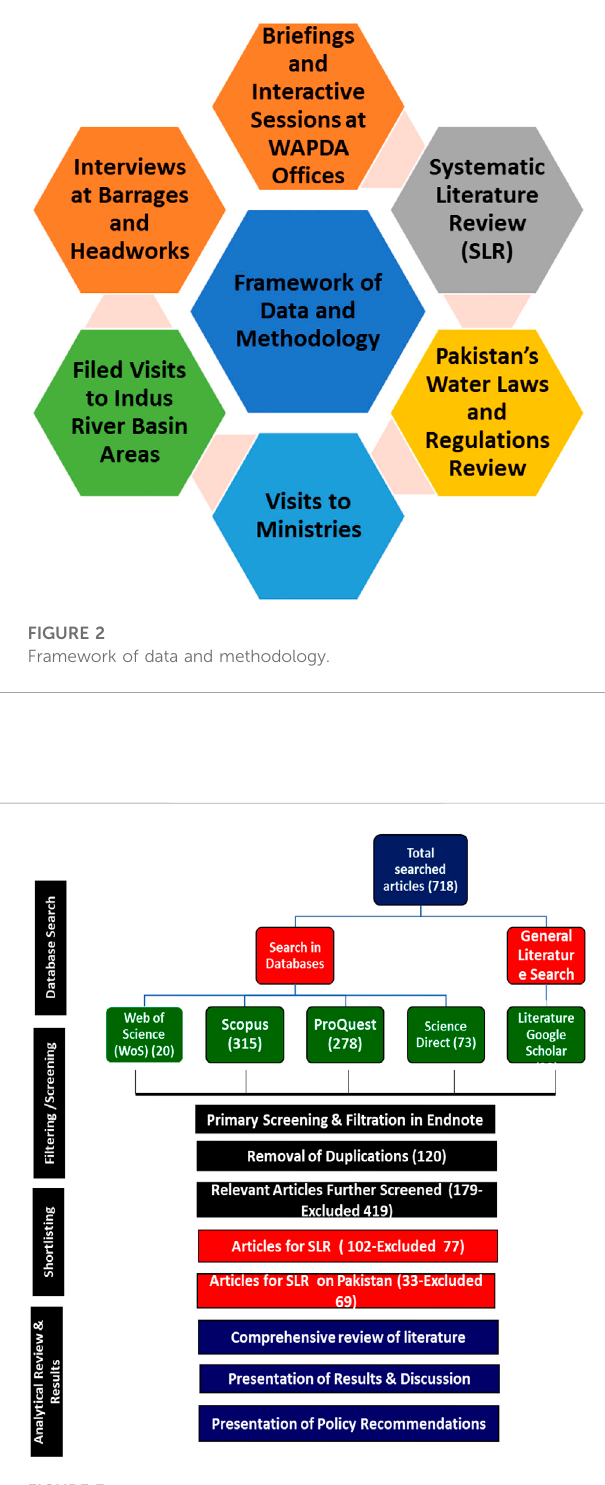
FIGURE 3 Process of systematic literature review